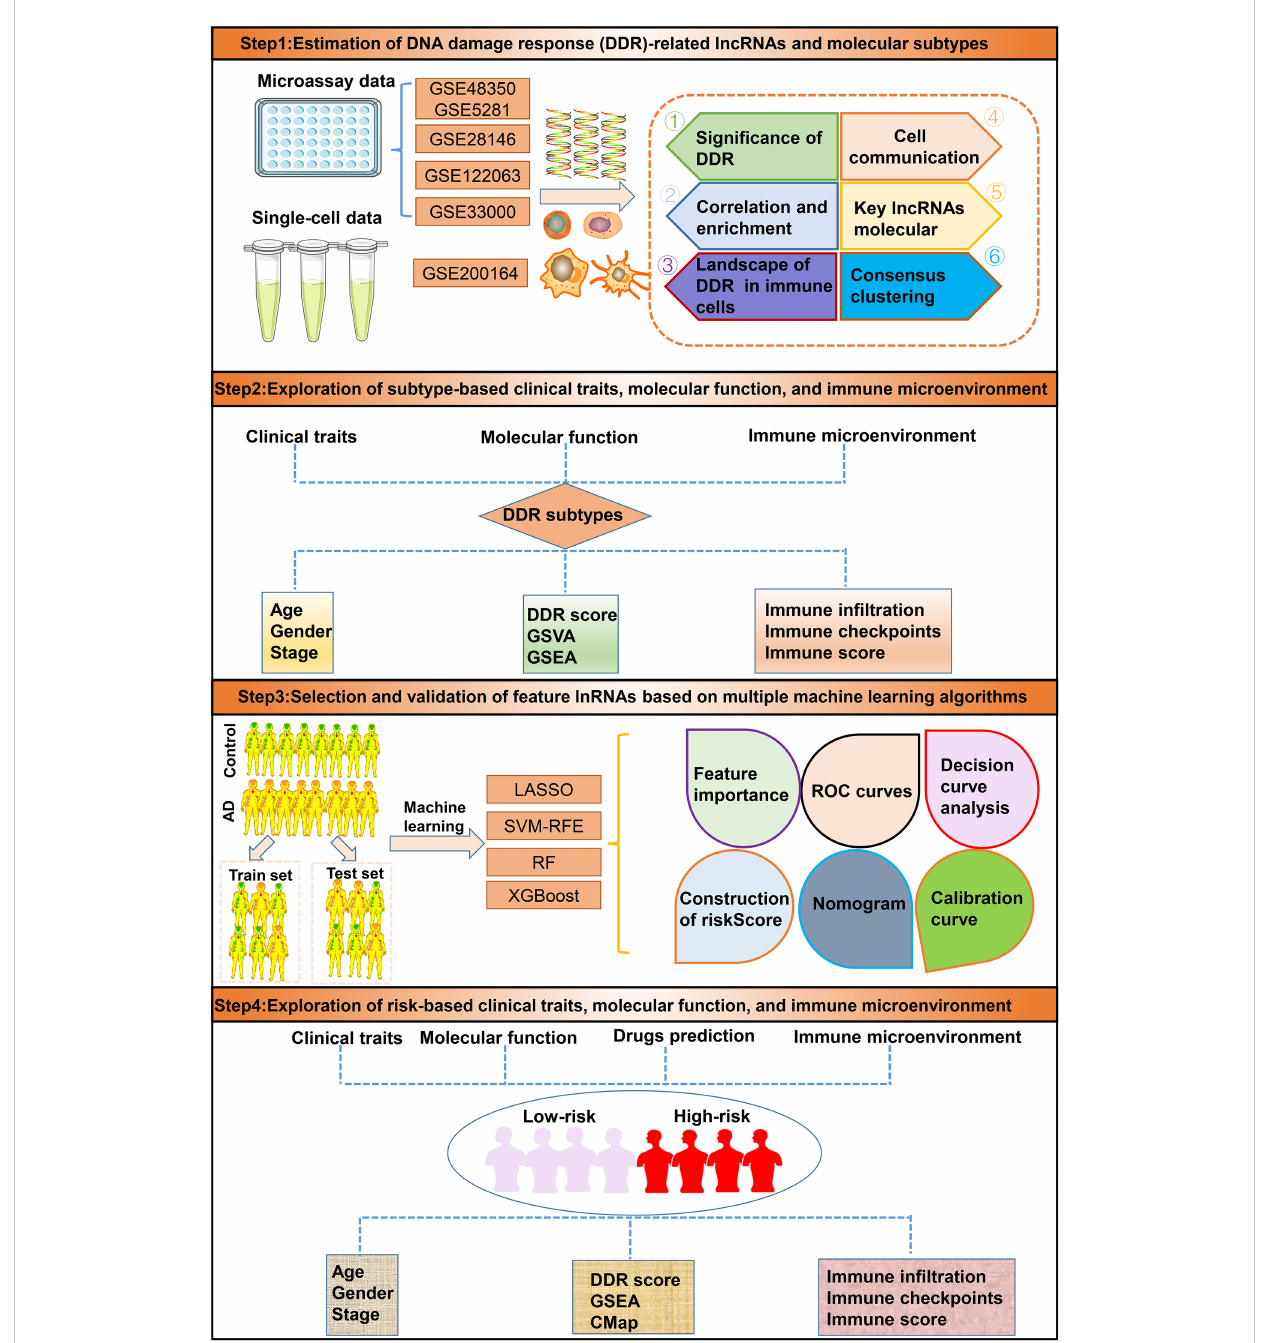
FIGURE 1 The study fl ow